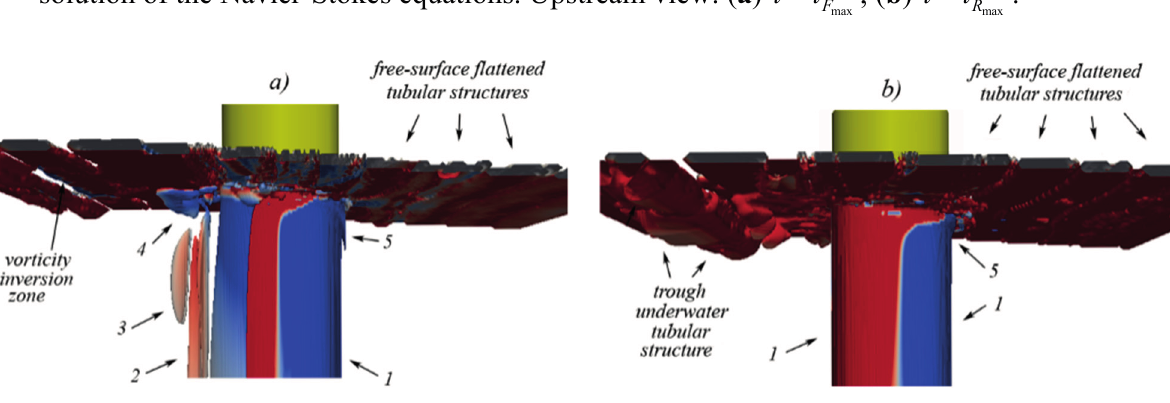
Figure 19. Close-up at the cylinder surface of viscous-flow structures as obtained from the solution of the Navier-Stokes equations. Upstream view: ( a )